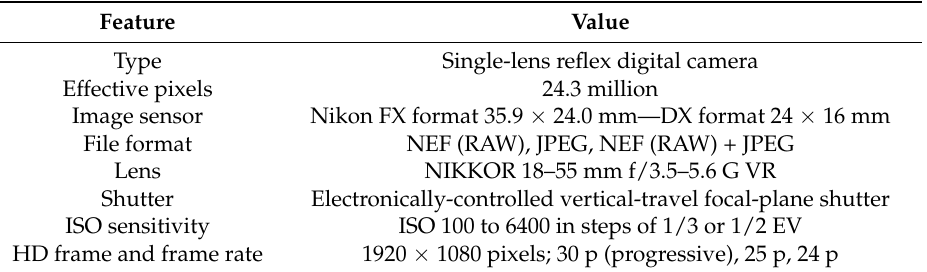
Table 2. Characteristics of the NIKON D610 digital